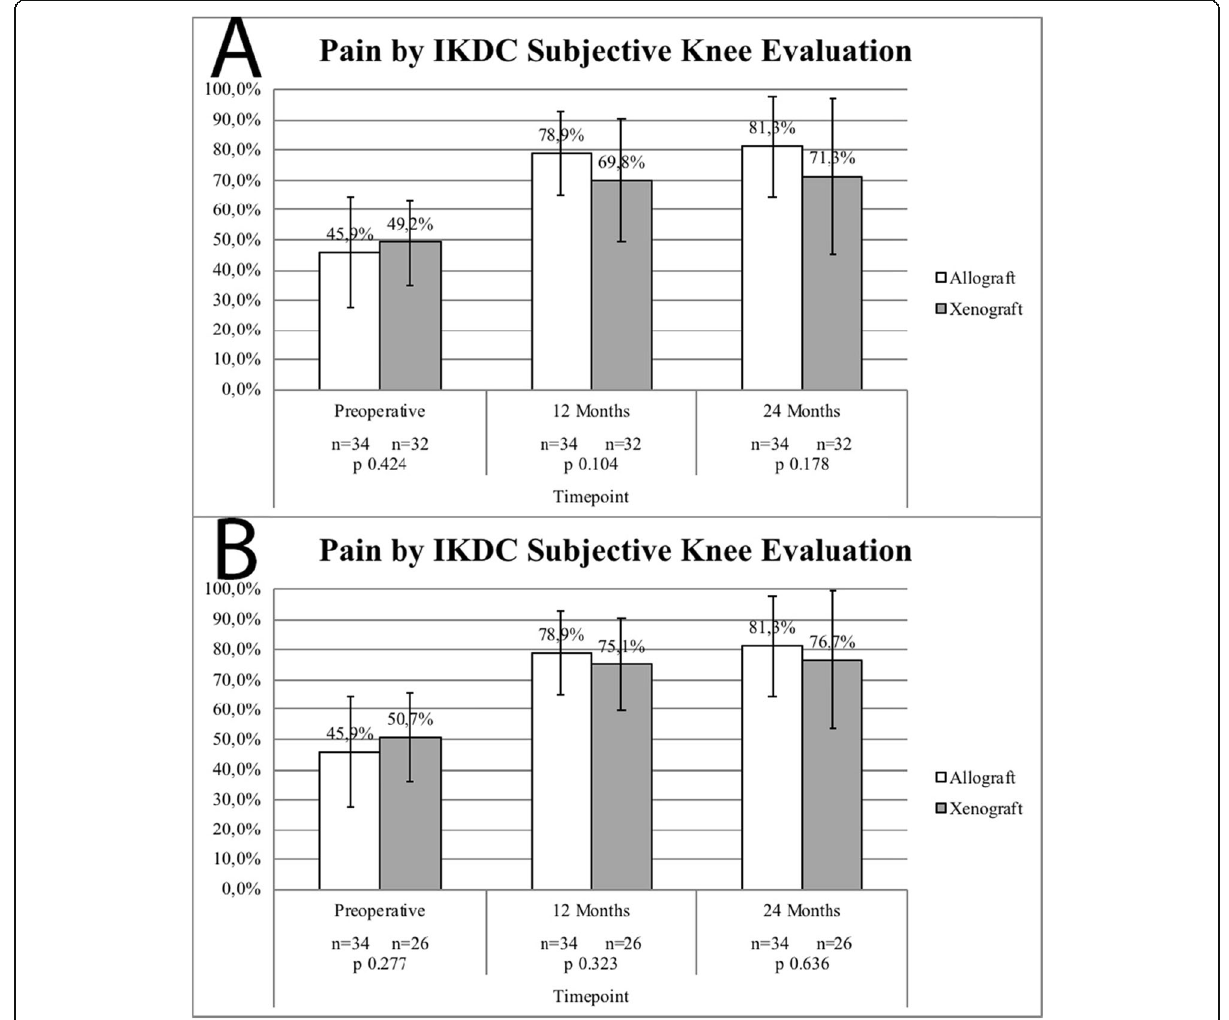
Fig. 3 Pain by IKDC Subjective Evaluation Scores - a , Missing/Contaminated Graft Subjects Included (LOCF); b , Missing/Contaminated Graft Subjects Excluded. No statistically significant differences were reported between study groups in both analysis (intention-to-treat vs. per